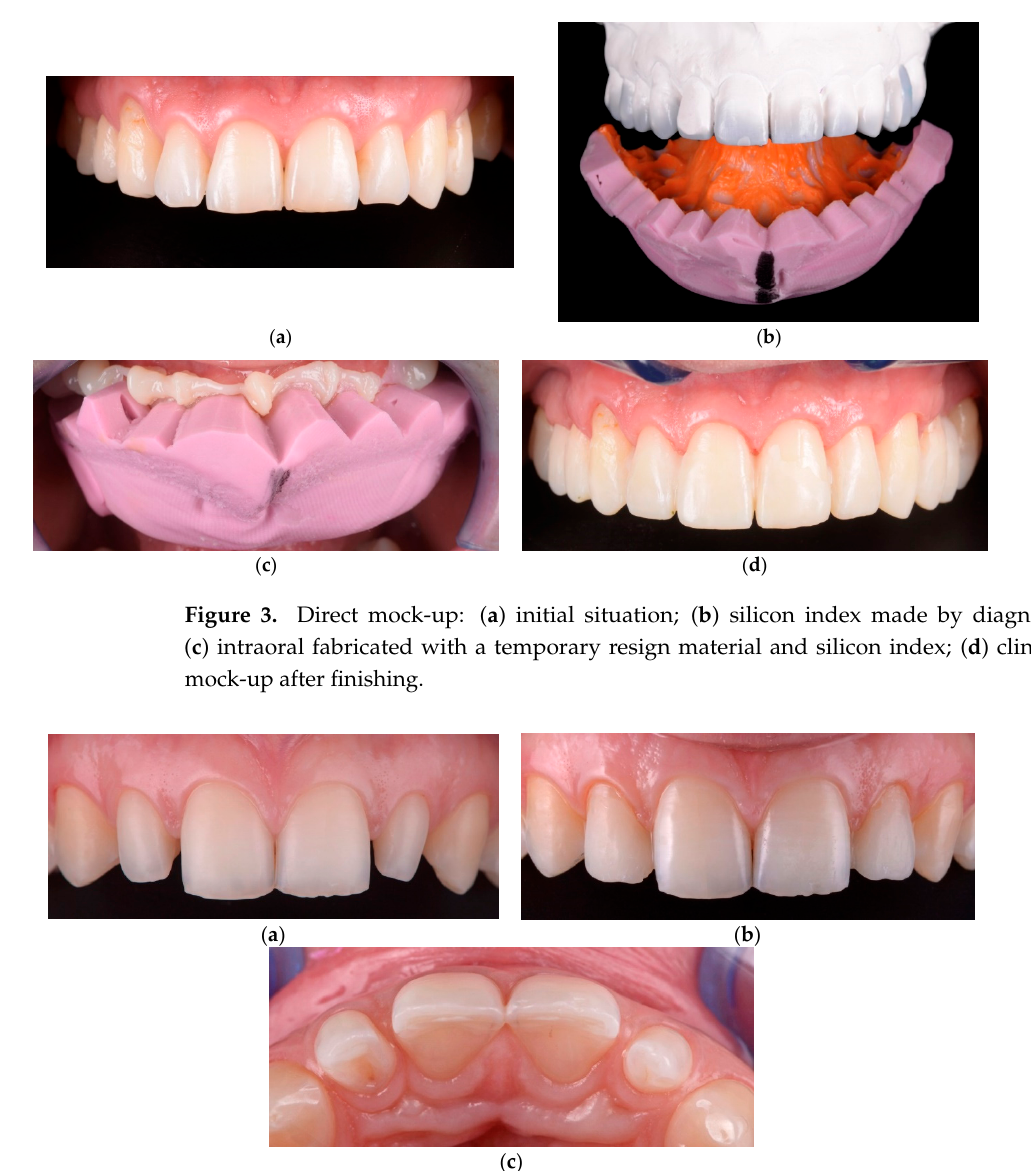
Figure 2. Diagnostic wax-up in which minimally invasive corrections with wax have been made. In all cases, the first option was an additive wax-up instead of substrative.